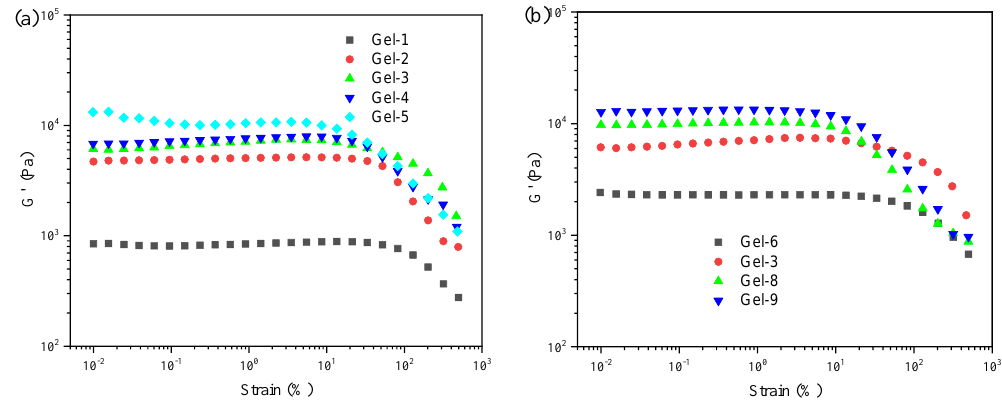
Figure 4. The strain amplitude sweep test of P(AAc- co -Am)/PVA double network hydrogels at a fixed angular frequency (10 rad/s) at 37 °C: ( a ) hydrogels with various Am/AAc ratios; ( b ) hydrogels with various Fe 3+ concentrations.